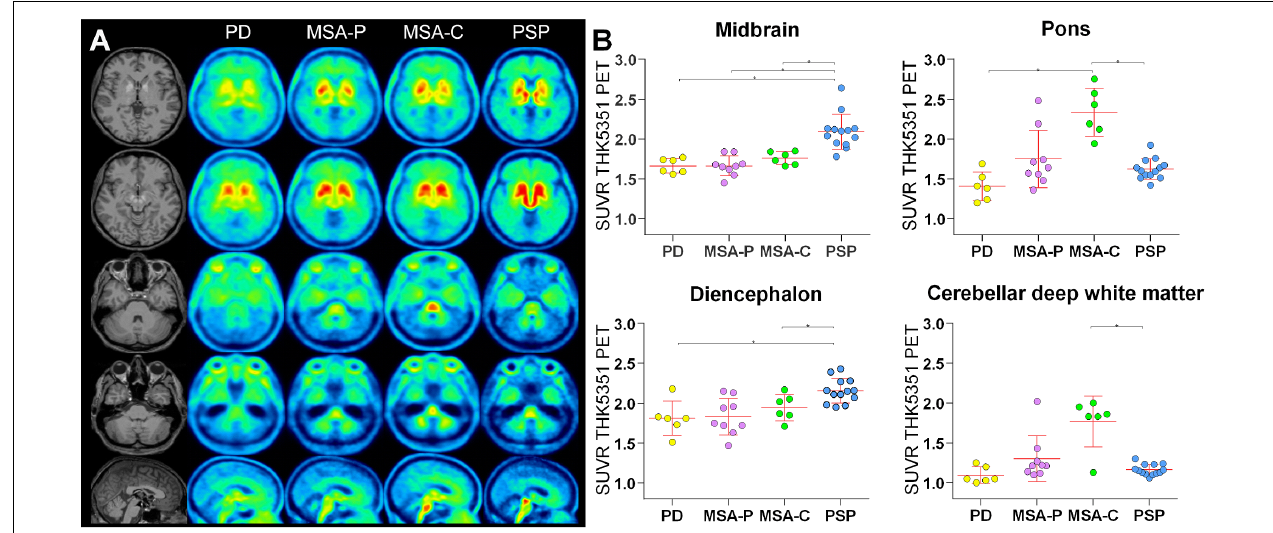
FIGURE 1 | [ 18 F]-THK5351 tracer uptake. (A) High midbrain uptake in axial and sagittal slices allows visual discrimination of the PSP patient group from other patient groups. Significantly higher [ 18 F]-THK5351 uptake in the diencephalon was detected in PSP patients compared to PD and MSA-C patients. In contrast, in MSA-C patients, but not in MSA-P patients, [ 18 F]-THK5351 uptake was especially high in the pons and cerebellar deep white matter. (B) Tracer uptake in the midbrain, pons, diencephalon, and cerebellar deep white matter. ∗ indicates significant